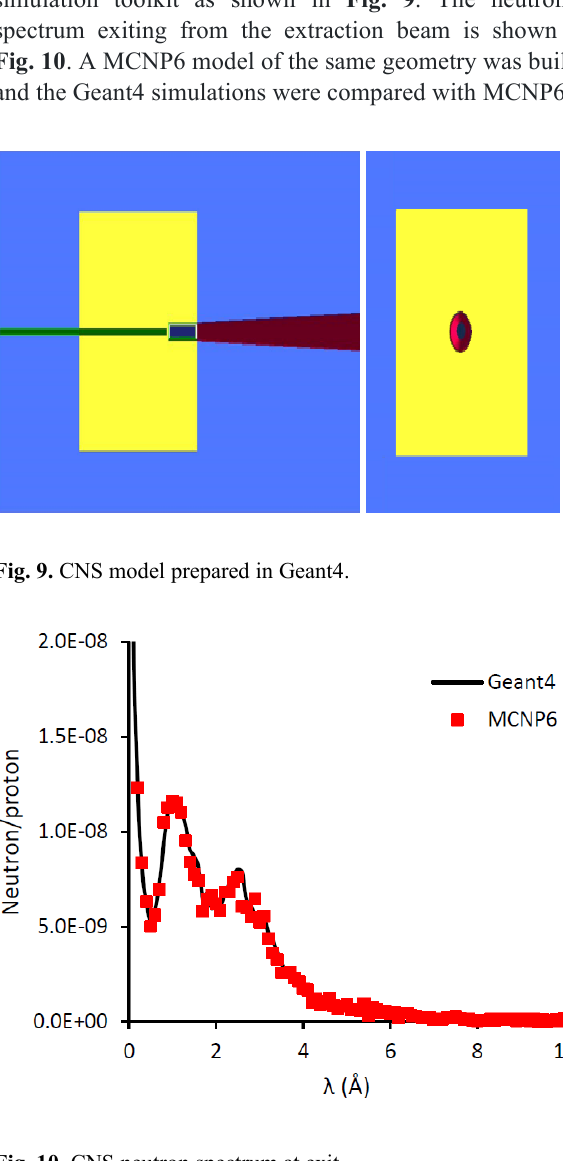
Fig. 10. CNS neutron spectrum at exit.